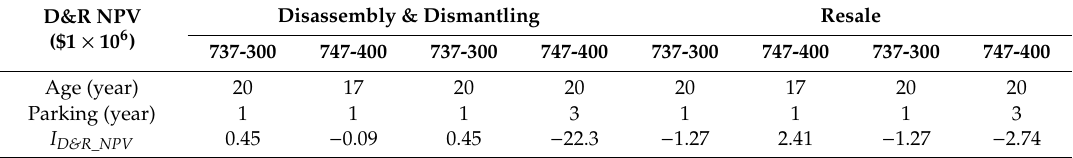
Table 13. Disposal and recycle NPV for 737-300 and 747-400 cases ( n D&R = 3, I = 8%) (2005